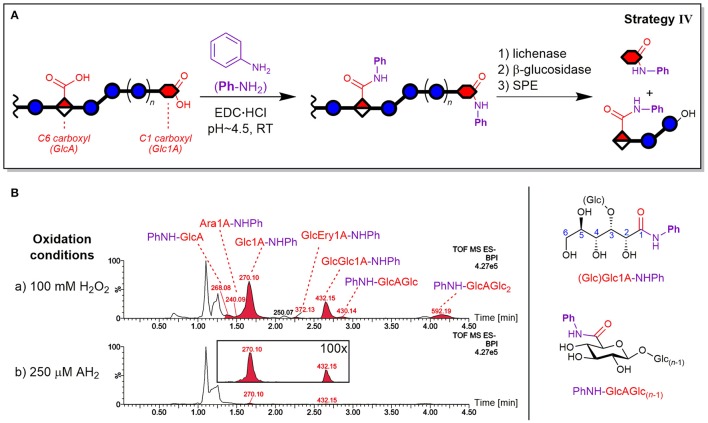
Depiction of (A) carboxylic acid labeling strategy IV by EDC-mediated amidation of oxidized β-glucan with aniline (PhNH2) and enzyme digestion/SPE steps analogous to strategy II (see Figure 4). (B) The resulting base peak ion chromatograms (BPI) from oxidation of barley β-glucan (BBG) under (a) harsh and (b) mild conditions after the CO2H sample preparation (basic eluent). The peaks are labeled with their base peak ion m/z and corresponding structure (chemical structures on the right-hand side). The insert under (b) shows 100x zoom of overlaid extracted ion chromatograms of m/z 270 and 432. Glc, glucose; Glc1A, gluconic acid; GlcA, glucuronic acid; Ara1A, arabinonic acid; Ery1A, erythronic acid; AH2, ascorbic acid; Ph, phenyl; -NHPh or PhNH-, aniline amide (anilide) of acid species; EDC, ethyl-3-(3-dimethylaminopropyl)carbodiimide.